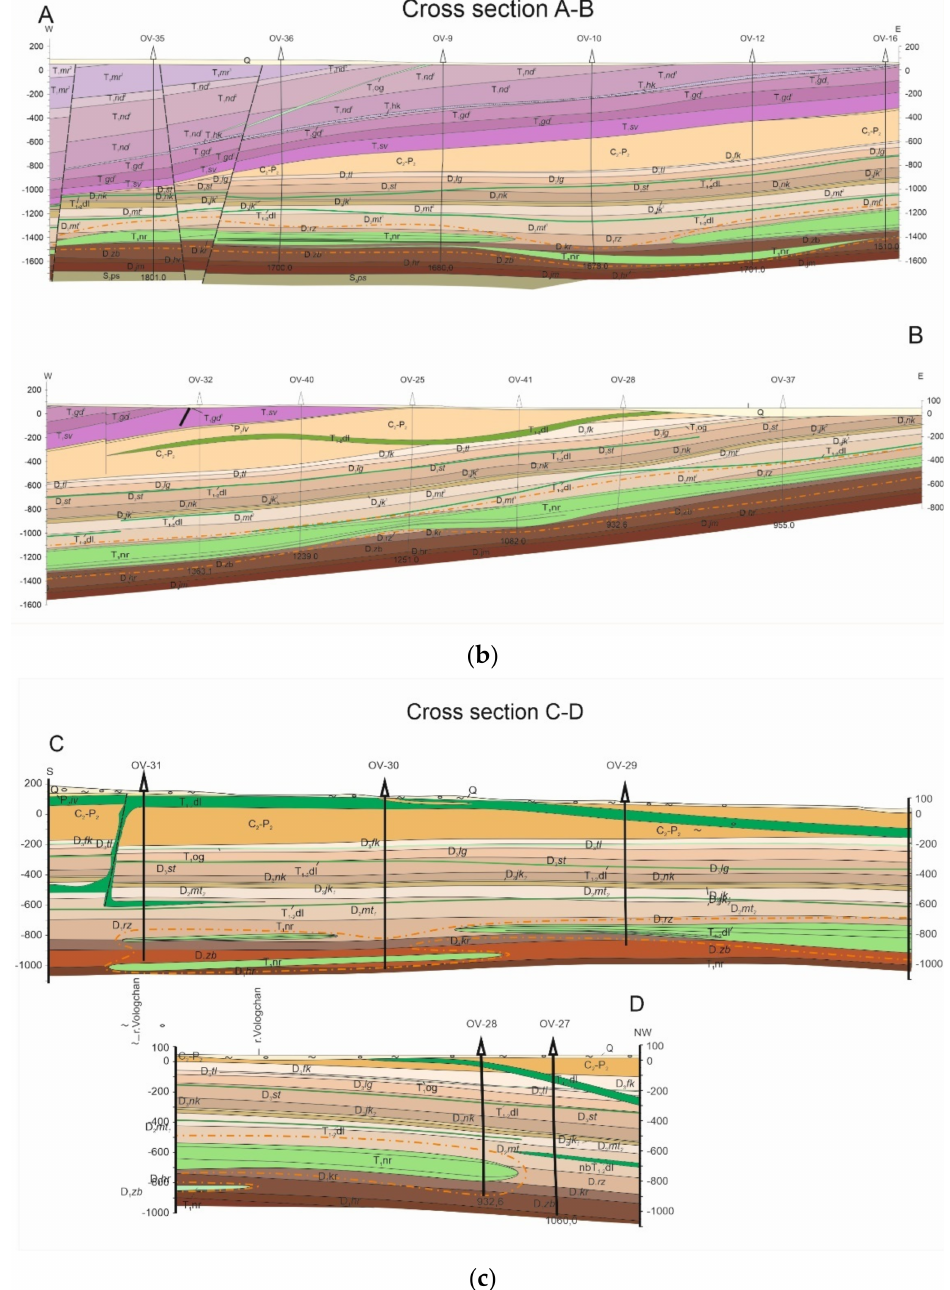
Figure 5. Geologic map ( a ), and cross sections ( b , c ) of the Pyasinsky-Vologochansky intrusion (after Norilskgeology Ltd. data, with the authors’ corrections). The area is shown as “2” in Figure